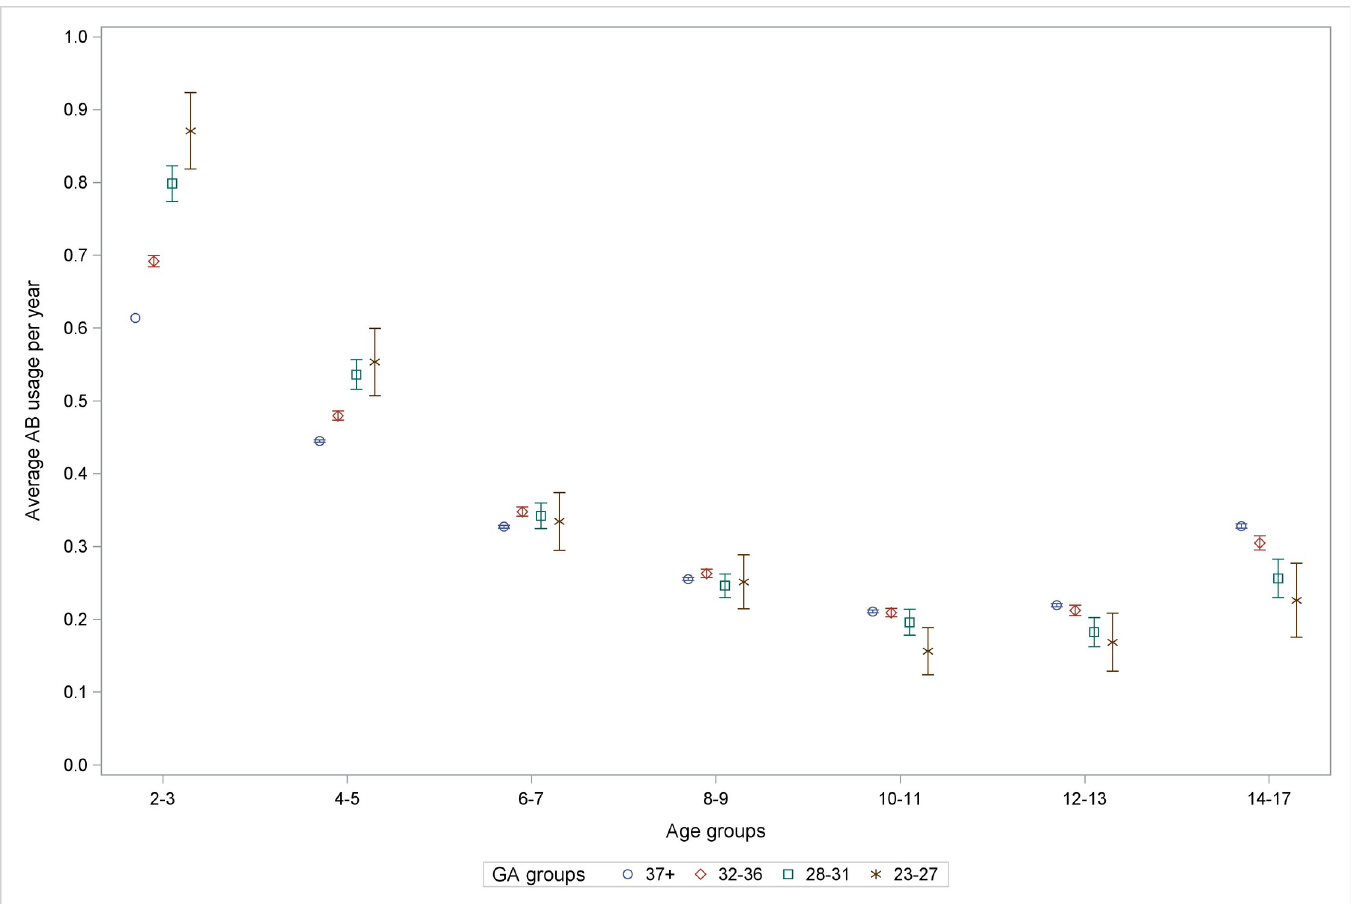
Fig 2. Average antibiotic courses purchased per child per year in GA-groups. Illustrates gradual decrease of the GA-effect up to and including age group 6–7 years, and in older age group an inverse relationship in age groups. The reference group was GA 37+ at age 2–3 year in the years 1997–2001. Adjusted for birth year, sex, SGA, maternal educational level, cesarean section, older sibling, acute respiratory disease and bronchopulmonary dysplasia. GA: gestational age, AB: antibiotics.